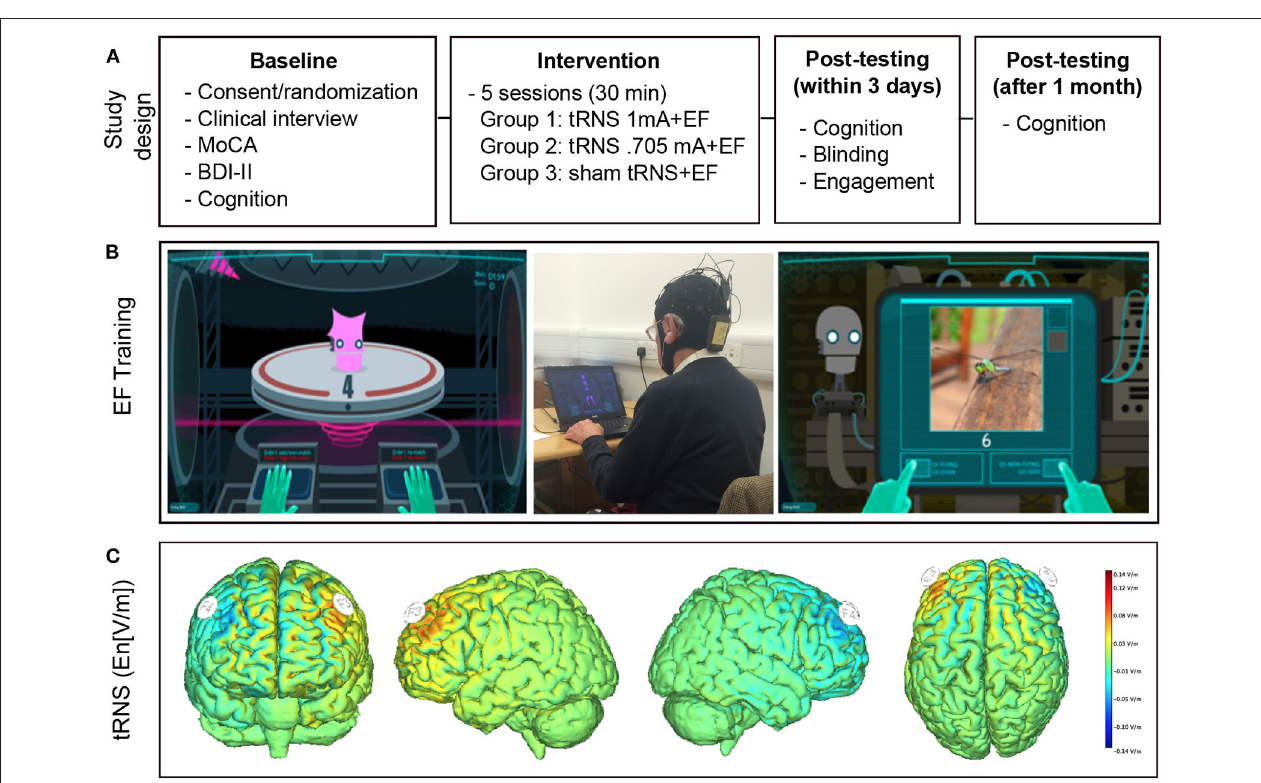
FIGURE 1 | Experimental design and intervention. (A) Experimental Design. After baseline testing participants were randomized to receive executive function training combined with real tRNS (1 or 0.705mA) or sham tRNS. Cognitive tests were repeated immediately after and 1 month after the intervention. (B) Cognitive training. Examples of single (left panel) and complex tasks (right panel). The middle panel depicts the intervention setup. (C) Modeling of the current flow. Stimulation was delivered over the dorsolateral prefrontal cortex and stimulation onset coincided with training onset. Electric field calculations (component of the electric field orthogonal to the cortical surface En [V/m]) were performed using a realistic head model (56). Positive values indicate that the field is directed into the cortical surface. Note that the protocol only depicts one instance of stimulation given that polarity changes continually during